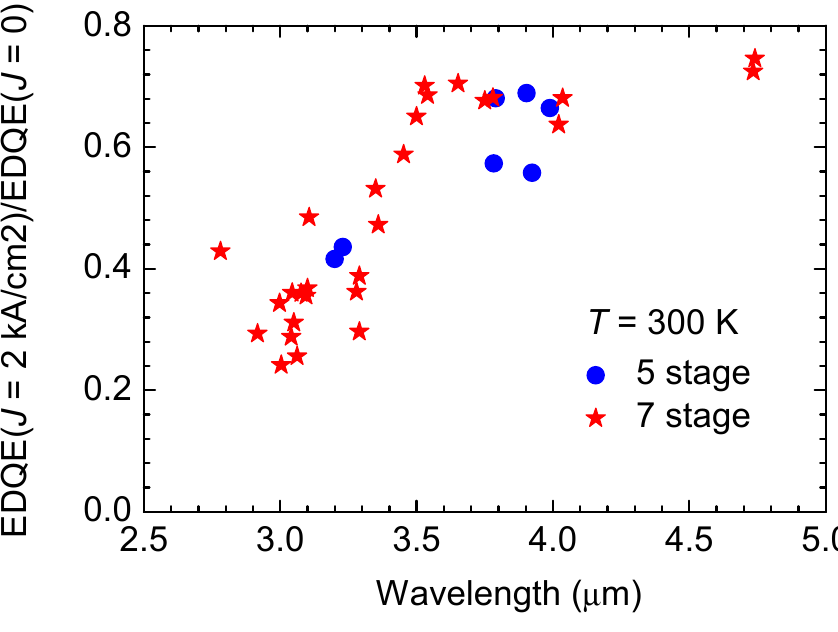
Figure 26. Ratio of the external differential quantum efficiency at J = 2 kA/cm 2 to the value extrapolated to J = 0 for 5-stage and 7-stage ICLs as a function of emission wavelength at room temperature.